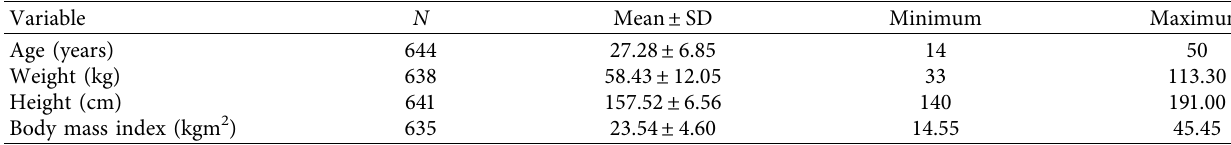
Table 3: Age and anthropometric information of mothers.